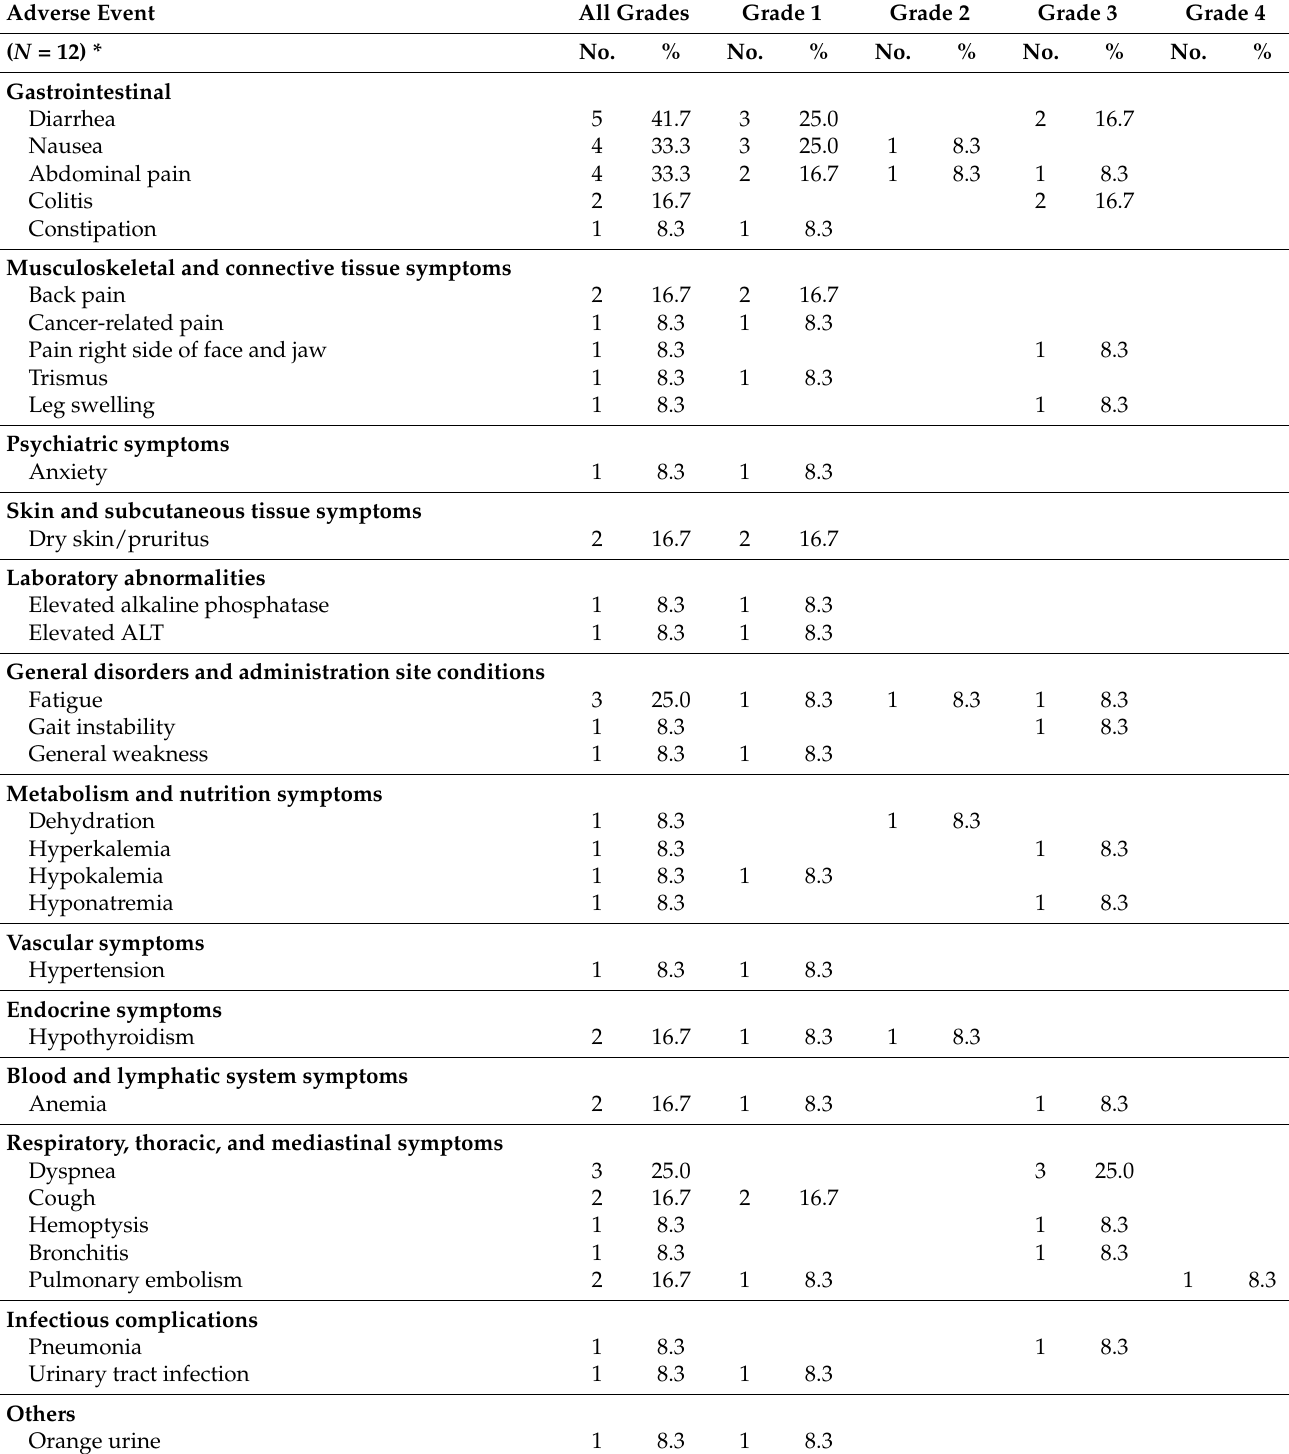
Table 3. Treatment-emergent adverse events (TEAEs) of patients treated with BBI608 and